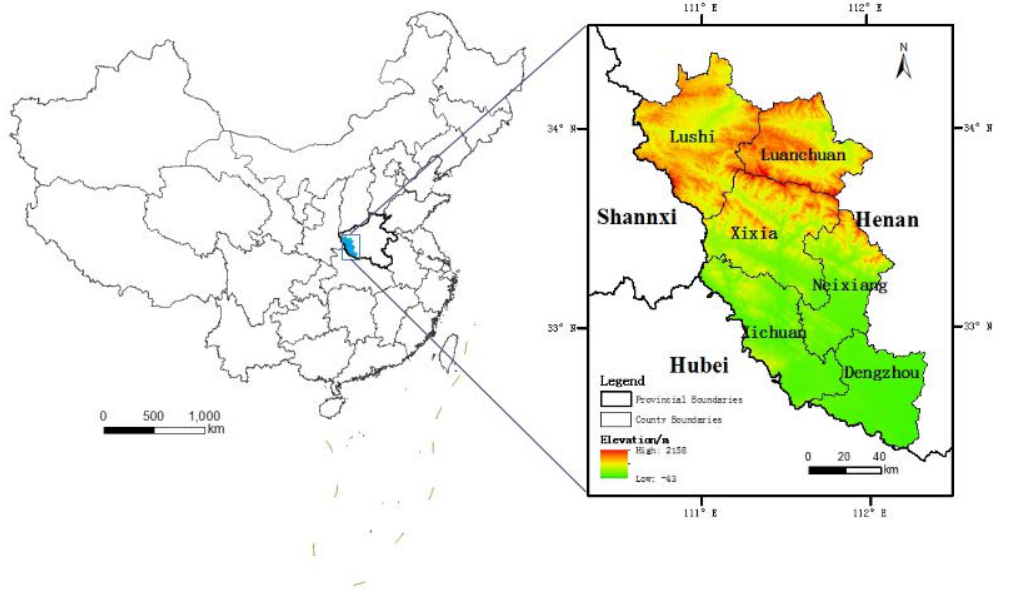
Figure 1. Location of Henan Water Source area of the Middle Route of the South-to-North Water Transfer Project.